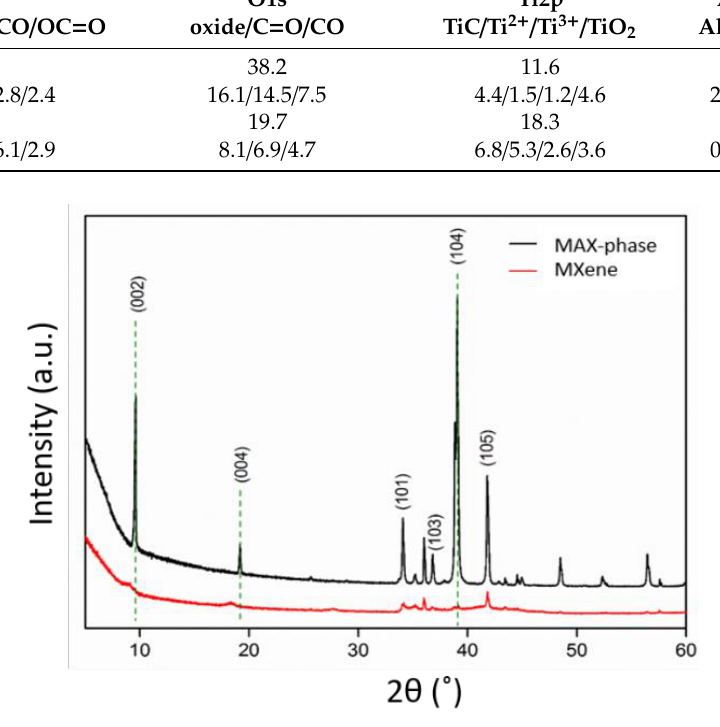
Figure 2. X-ray di ff raction (XRD) of MAX phase and MXene Figure 2. X-ray diffraction (XRD) of MAX phase and MXene particles.